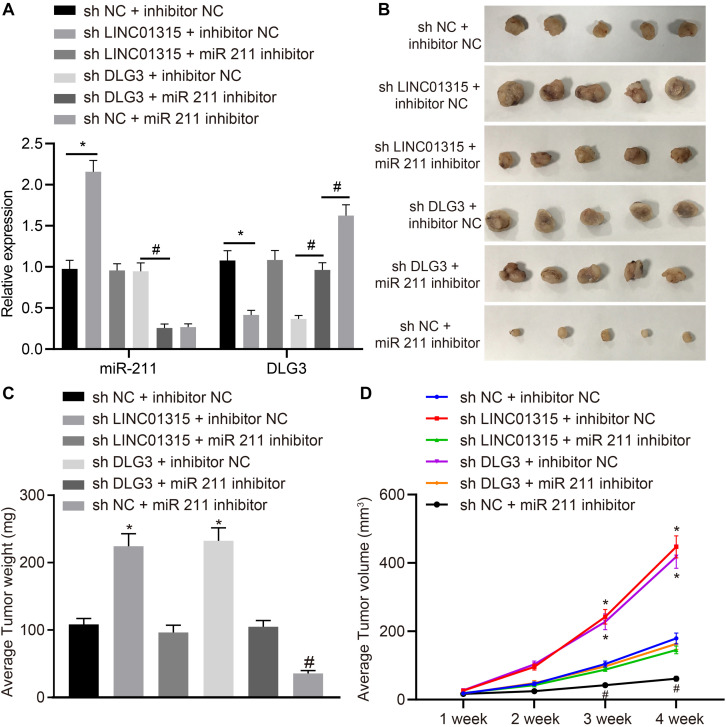
LINC01315 binds to miR-211 to increase the expression of DLG3 to further suppress xenograft tumor growth. (A) Expression of LINC01315, miR-211 and DLG3B determined by RT-qPCR in SAS cells transfected with sh-NC, inhibitor NC, sh-LINC01315, miR-211 inhibitor, and sh-DLG3 in combination. Nude mice were injected with SAS cells stably transfected with sh-NC, inhibitor NC, sh-LINC01315, miR-211 inhibitor, and sh-DLG3 in combination. (B) Representative images showing xenografts in nude mice; (C) Weight of xenograft tumors; (D) Volume of xenograft tumors measured every 1 week in nude mice; *p < 0.05 vs. the sh-NC + inhibitor NC group; #p < 0.05 vs. the sh-LINC01315 + inhibitor NC group or the sh-DLG3 + inhibitor NC group. The data were expressed as mean ± standard deviation and analyzed by one-way ANOVA. The tumor weight and volume were measured three times independently.